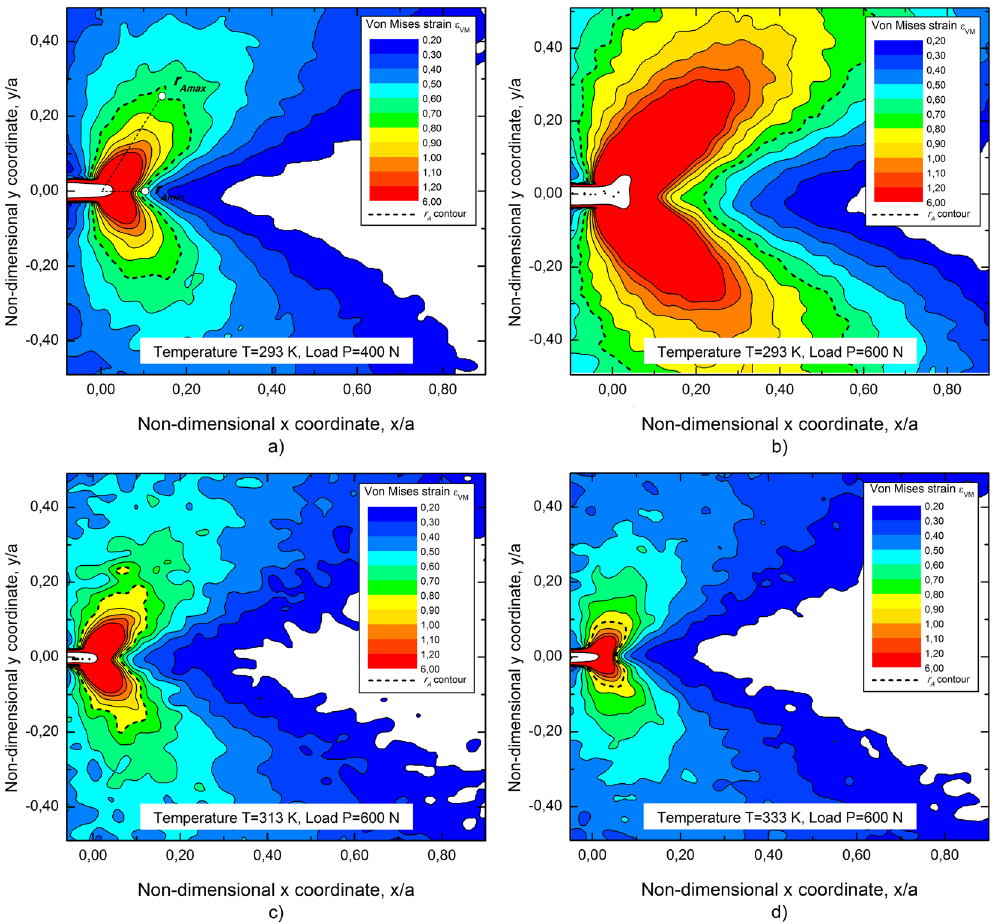
Figure 4. DIC strain contours obtained from SEC specimens at different thermo mechanical loading condition: ( a ) P = 400 N and T = 293 K; ( b ) P = 600 N and T = 293 K; ( c ) P = 600 N and T = 313 K; ( d ) P = 600 N and T = 333